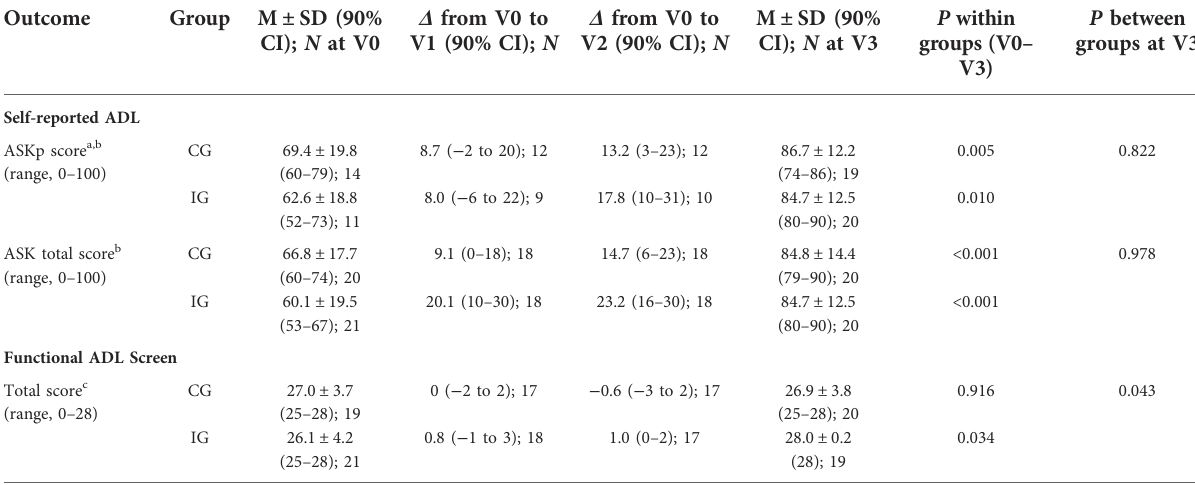
TABLE 5 Effects of exercise interventions on activities of daily living by group and